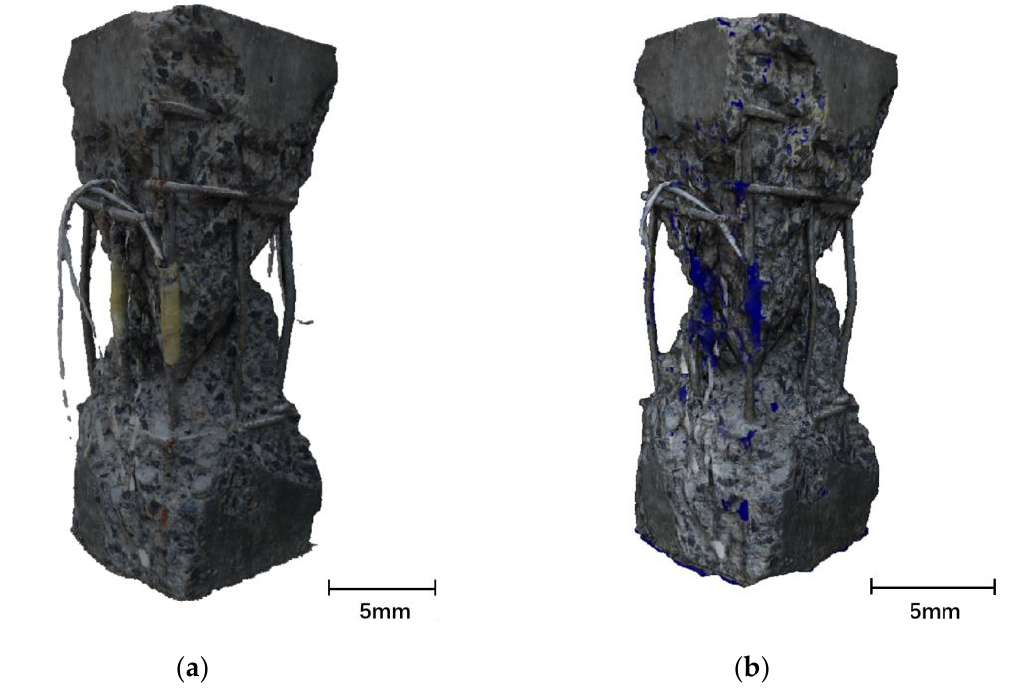
Figure 6. Comparison of the 3D models of the original image and the segmented image: ( a ) 3D reconstruction model of the original picture; ( b ) 3D reconstruction model of the segmented picture.